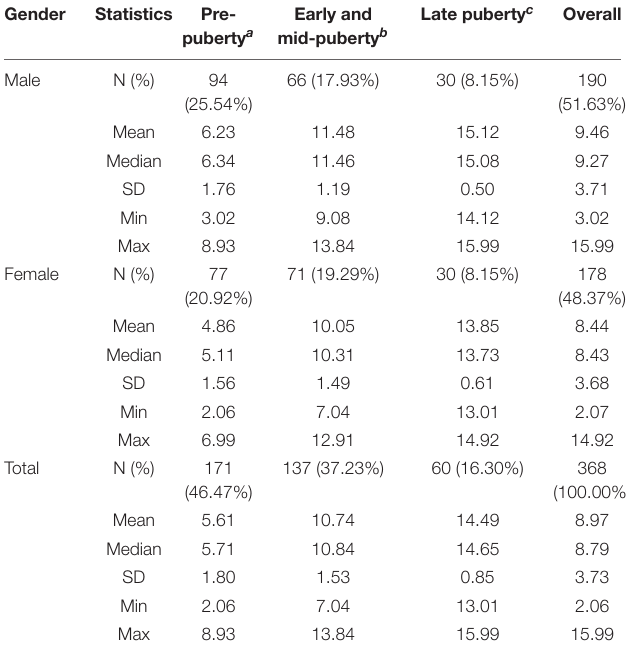
TABLE 1 | Summary of baseline